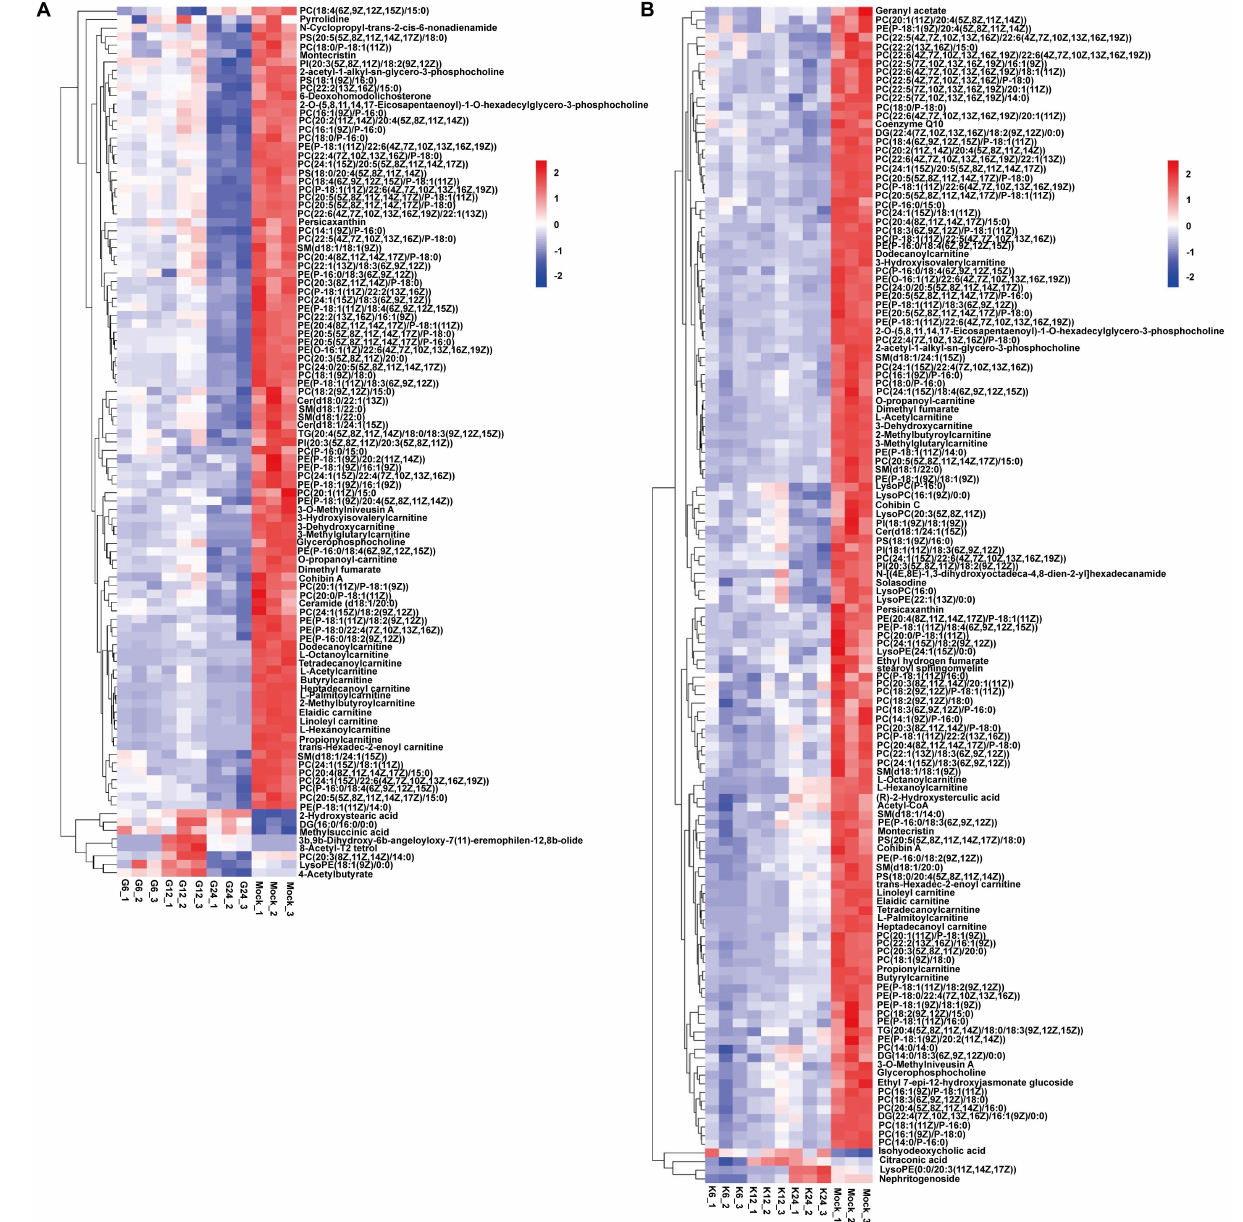
Figure 4. Heatmap analysis of 103 and 136 metabolites among PRV-G, PRV-K, and mock groups. Rows: metabolites; columns: samples. The color of each rectangle represents the relative level of the differential metabolites. Red: upregulated; blue: downregulated. ( A ) PRV-G; ( B )